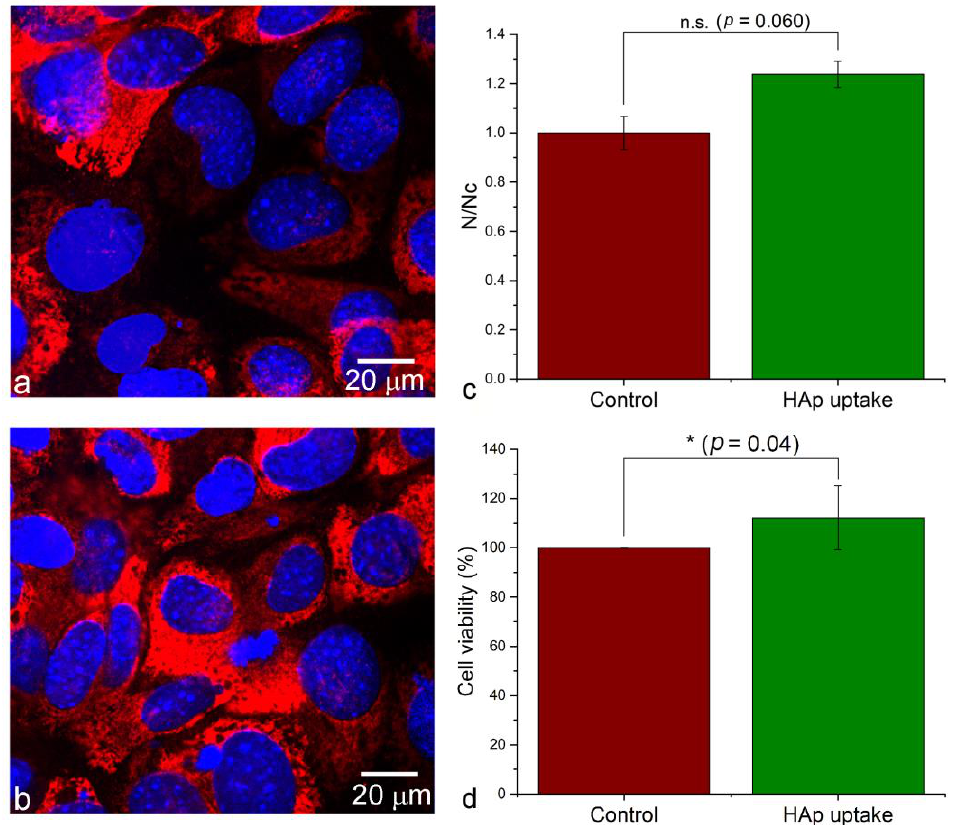
Figure 8. Control cells ( a ) and cells treated with the nanoparticles ( b ) stained for their nuclei (blue) and collagen production (red). Proliferation of control cells reseeded in cell culture dishes and cells that underwent the uptake of HAp nanoparticles prior to reseeding ( c ). hMSC viability of population subjected to HAp nanoparticle uptake relative to the viability of the control population ( d ). Data points in ( c ) and ( d ) represent averages (n = 2 − 4), error bars represent standard deviation, and p-values represent the confidence intervals for the statistical significance of the difference of the value of the sample group compared to the control.